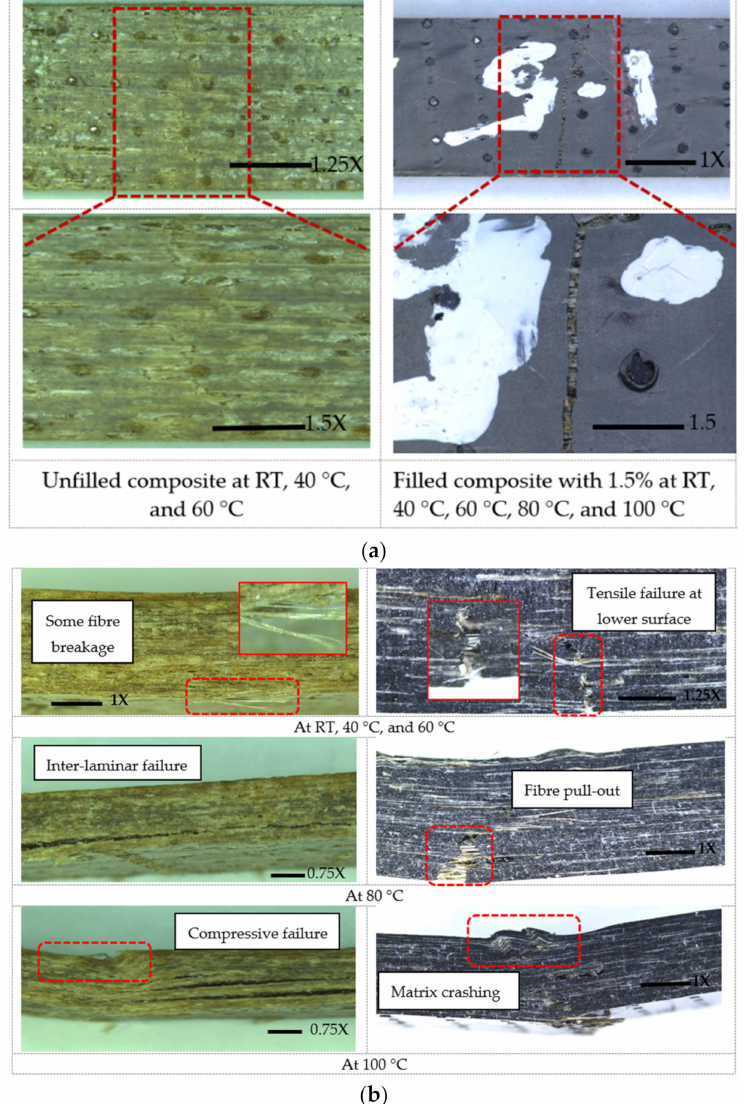
Figure 4. Flexural failure mechanisms for filled and unfilled composites at elevated temperature: ( a ) Tensile failures of hybrid composites with 0% and 1.5% at elevated temperature; ( b ) description of failure from the side view of the sample with 0% and